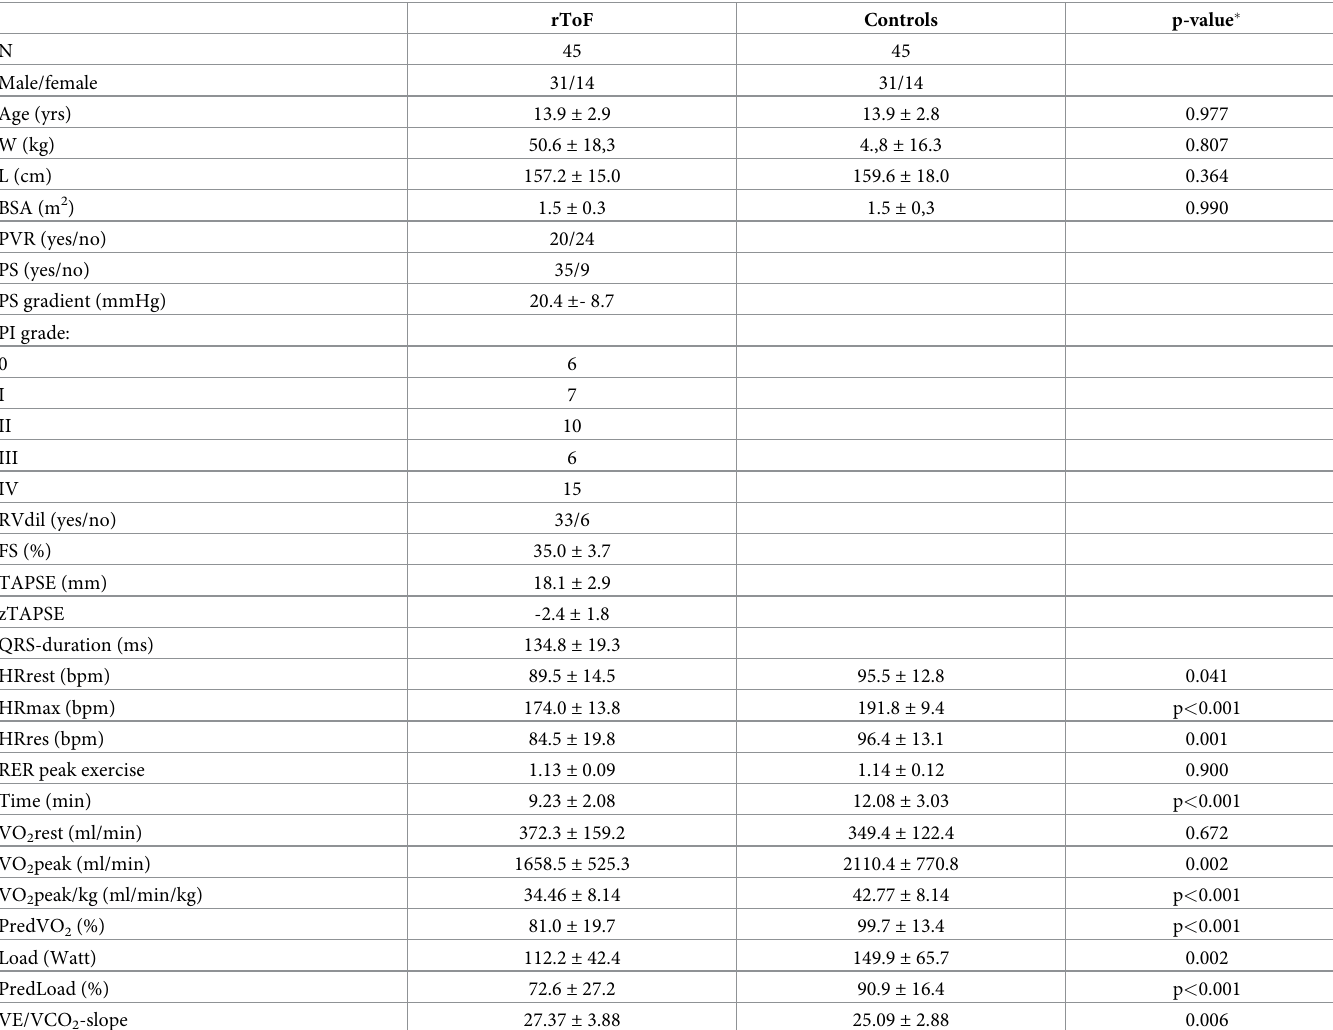
Table 1. Anthropometric characteristics and exercise tolerance parameters for rToF patients compared to healthy